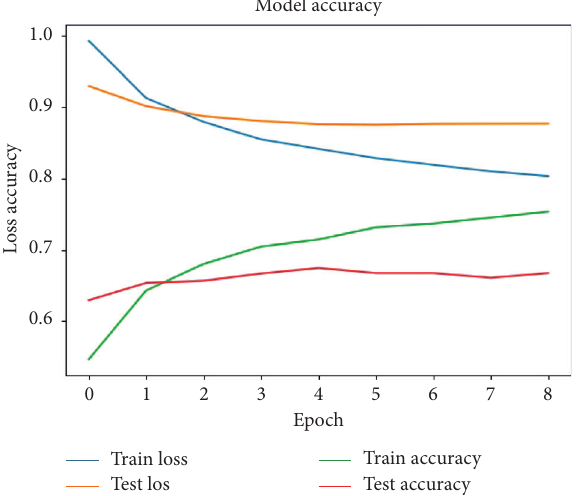
Figure 2: The learning curves of the training process. Table 1: Performance metrics of the LSTM